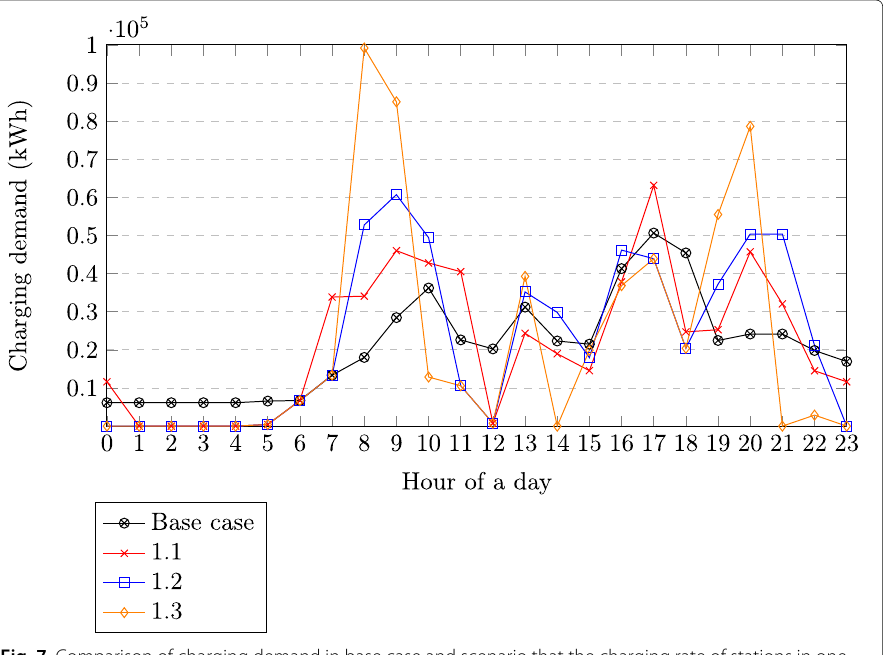
Fig. 7 Comparison of charging demand in base case and scenario that the charging rate of stations in one region is